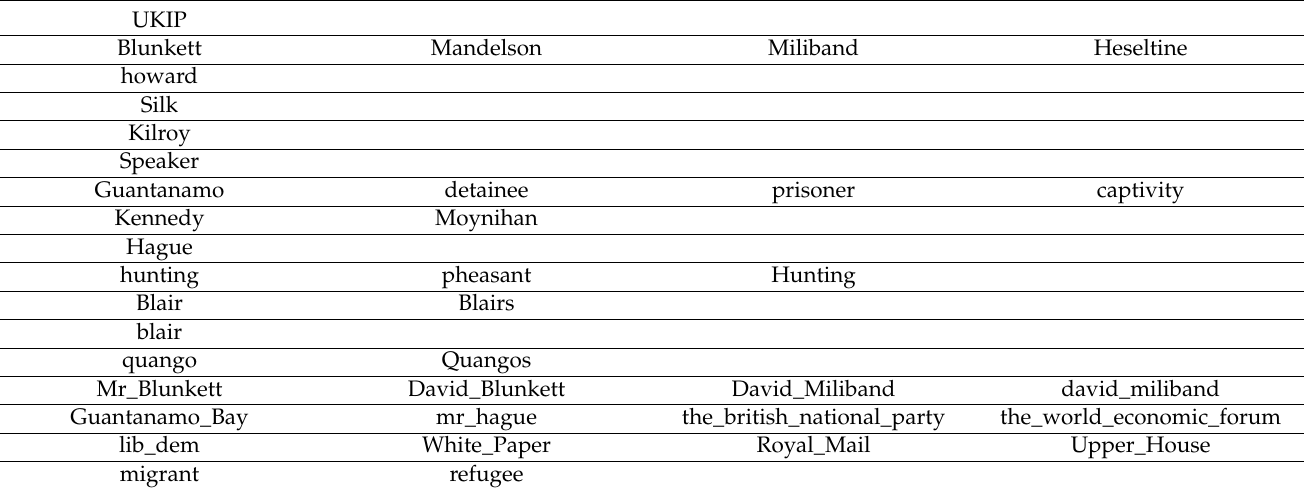
Table 2. Principle of stratified topic view. Terms with high r values are complemented through other topic terms from their fastText embedding